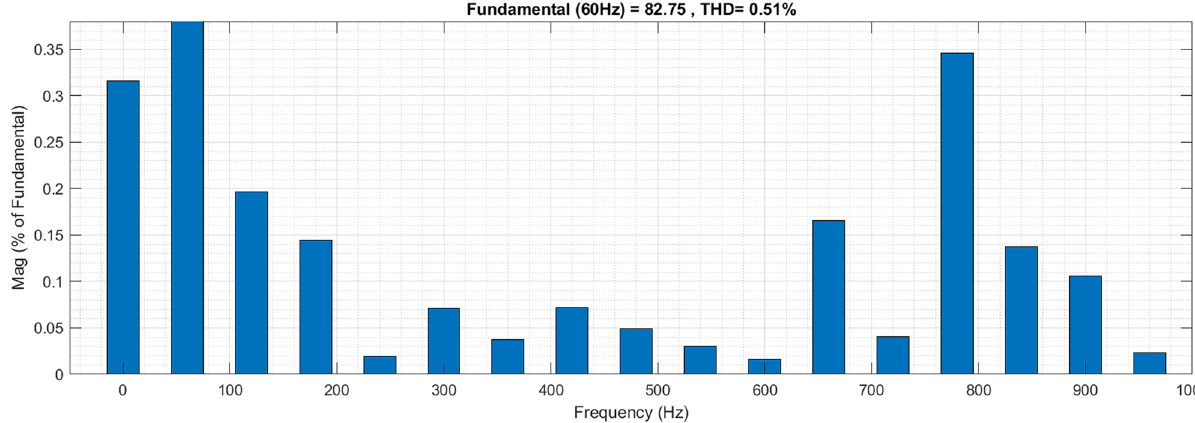
Figure 6: i abc THD. Scenario 1 – connection to a balanced power grid.